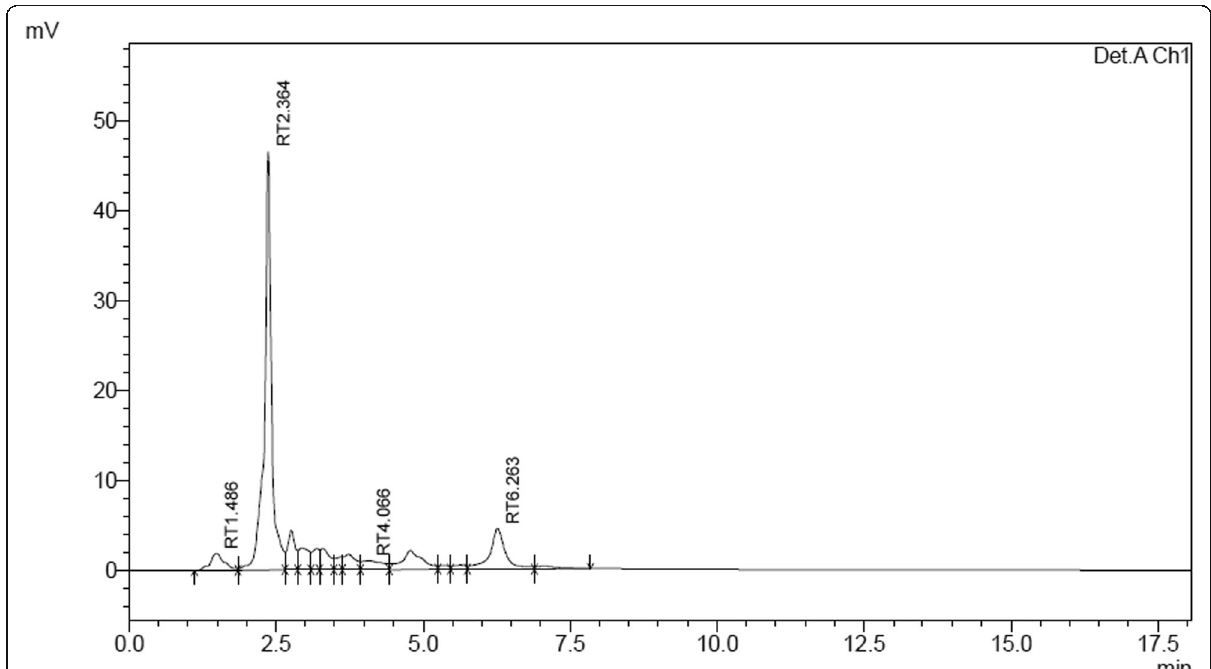
Fig. 1 Chromatogram of double blank (plasma